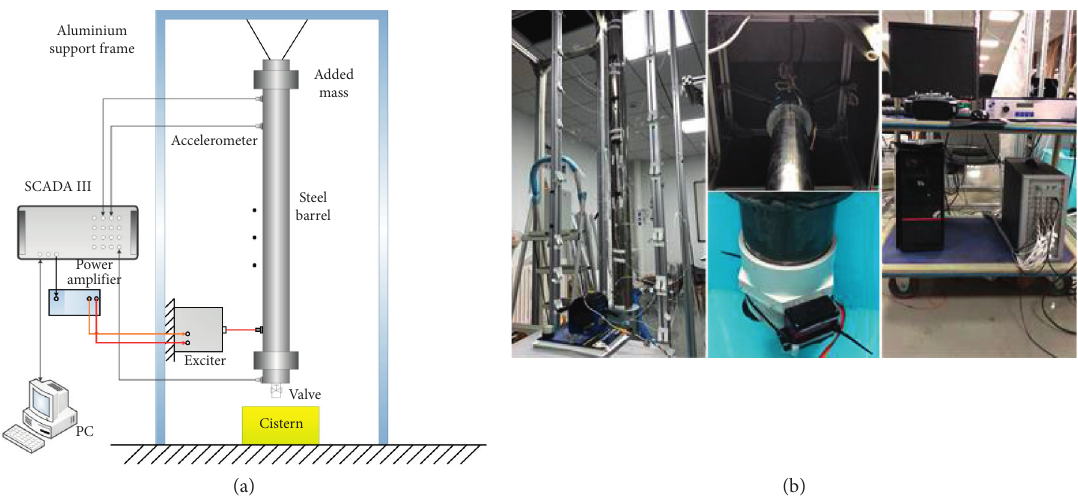
Figure 1: Schematic diagram (a) and setup (b) of the experimental exciter (Modal Shop 2025E) and a power amplifier allows mass of water varying from 15.7 kg (full state) to 0 kg (SmartAmp 2100E21-400). An impedance head (PCB (empty state), and the diameter of the hole at the bottom 288D01), a laser range finder (Y1TA100MHT88), and 9 controls the flow rate. The exciter system consists of an